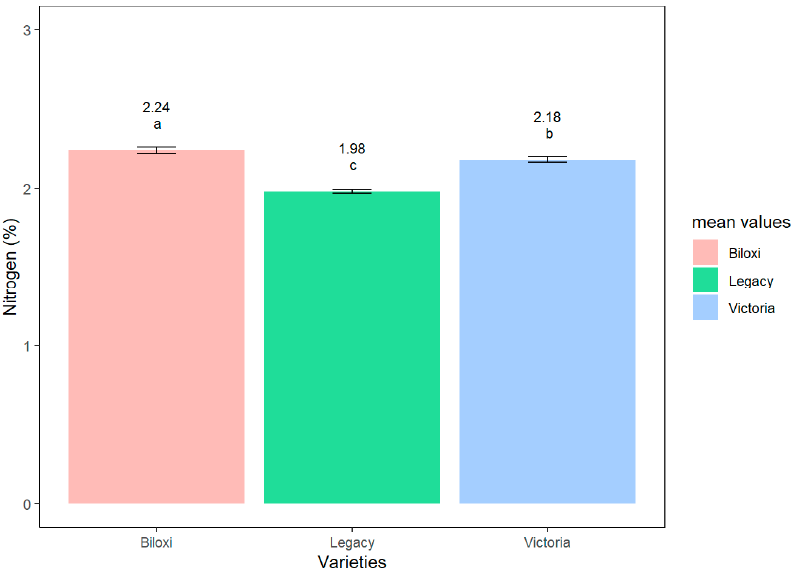
Figure 5. Comparison of the foliar Nitrogen content in Biloxi, Legacy and Victoria variety blueberry plants. Different letters indicate significant differences ( p < 0.05) according to the Tukey’s multiple comparison test of means. Vertical bars in each average indicate the standard error (n = 30).